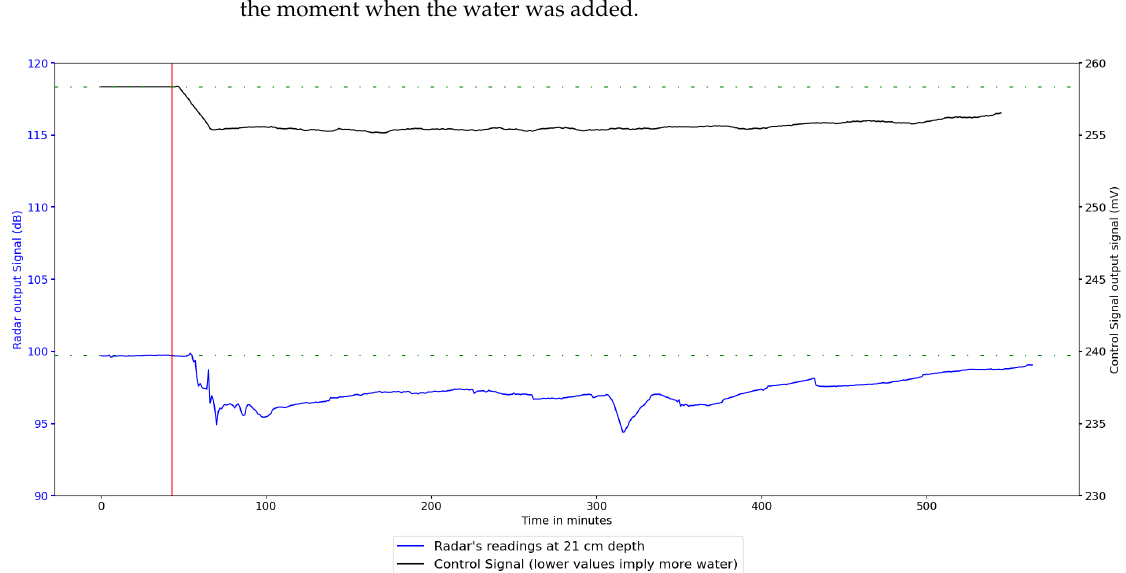
Figure 6. RADAR’s readings vs. control signal at 21 cm depth. The vertical red solid line represents the moment when the water was